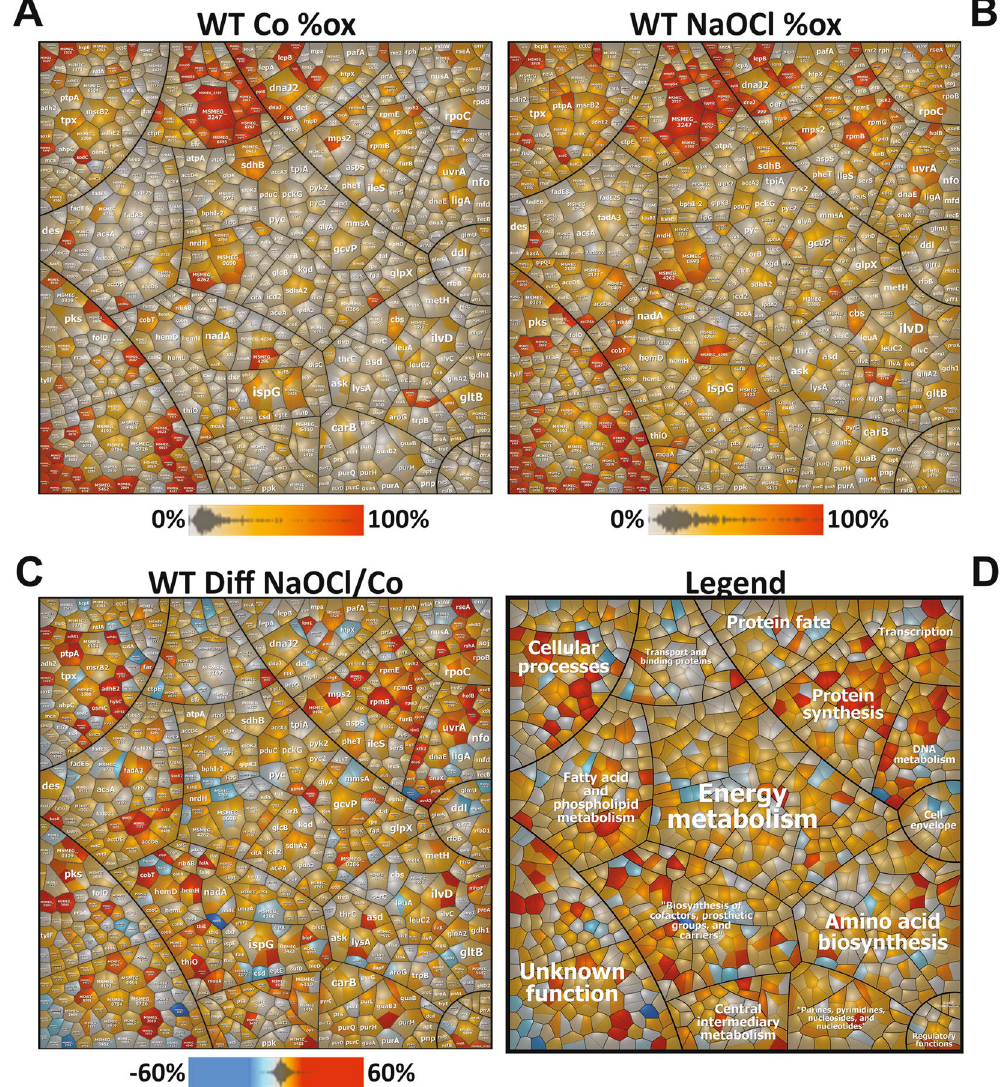
Figure 5. Voronoi redox treemaps show the percentages of thiol-oxidation levels of all Cys-peptides identified in the redox proteome of the M. smegmatis wild type. The “ Voronoi redox treemaps ” show the percentages of thiol-oxidations of 1098 Cys-residues identified using OxICAT in the wild type control ( A ) and 30 min after exposure to 1 mM NaOCl stress ( B ). The grey-yellow-red color gradient denotes 0–100% oxidation. The Voronoi redox treemap in ( C ) visualizes the percentages of oxidation changes under NaOCl stress using a blue-red color gradient ranging from − 60 to + 60% oxidation. The treemap in ( D ) is used as legend for the functional classification of the proteins displayed in ( C ). The treemaps are generated based on the OxICAT data presented in Table S4 using the Paver software (Decodon) and proteins were classified according to the M . smegmatis TIGRfam